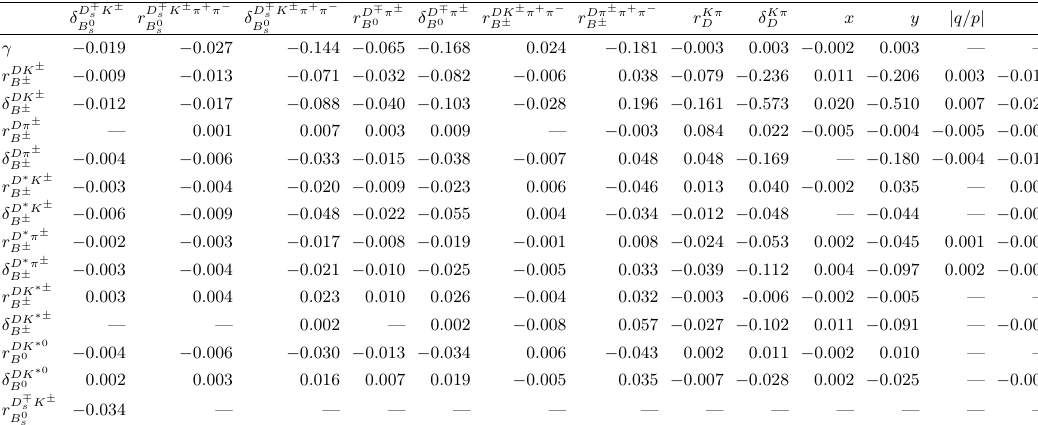
Table 8 . Correlation matrix of the fit result, part 2 of 3. Values smaller than 0 . 001 are replaced with a —